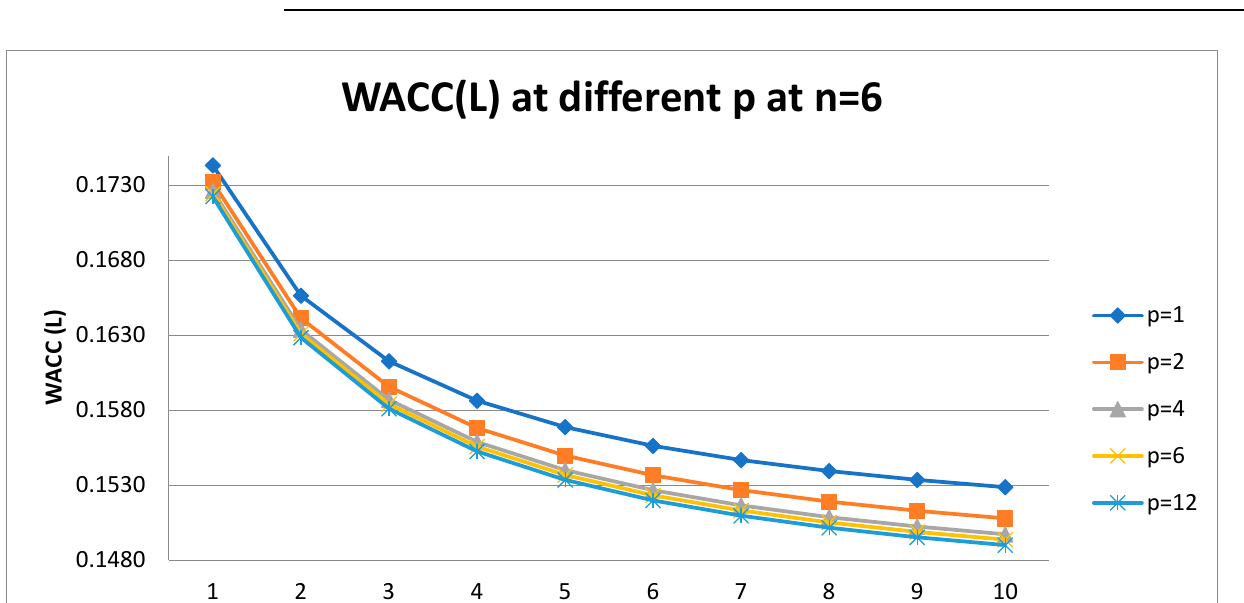
Figure 7. Dependence of the weighted average cost of capital, WACC , on leverage level L at different frequency of payments of tax on profit p for six-year company.